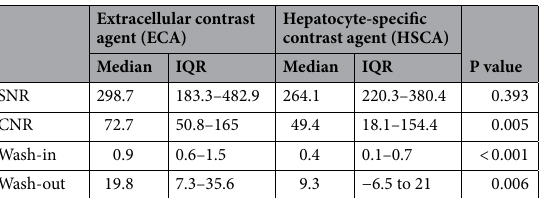
Table 1. Quantitative Analysis of signal-to-noise ratio (SNR), contrast-to-noise ratio (CNR), wash-in, and wash-out of HCC lesions in ECA-enhanced MRI and